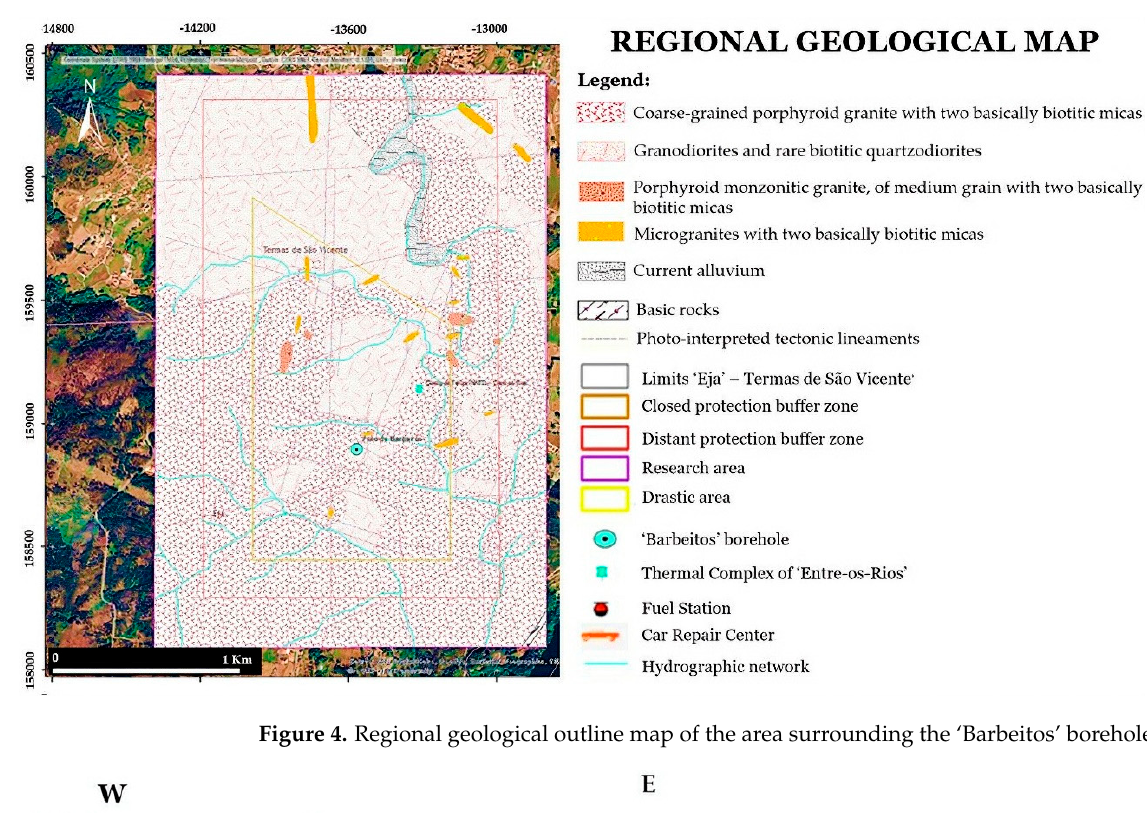
6 of 21 Figure 3. Model digital terrain and slope map of the area surrounding the ‘Barbeitos’ borehole. In terms of the local geology, granitic rocks dominate the research area (Figure 4). The granitic rocks in the research area are part of a band of Variscan granites that extends